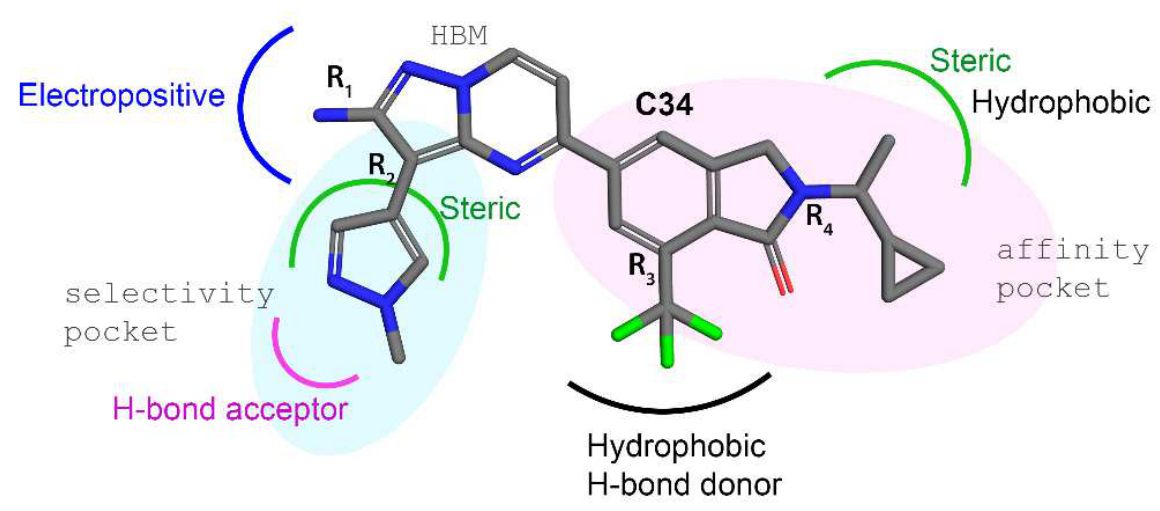
Figure 10. Structure–activity relationship analysis by taking C34 as a reference. Based on the SAR study, we designed 100 new compounds, as shown in Supple- mentary Table S15, by substituting chemical fragments at positions R 2 , R 3 , X1, and X 2